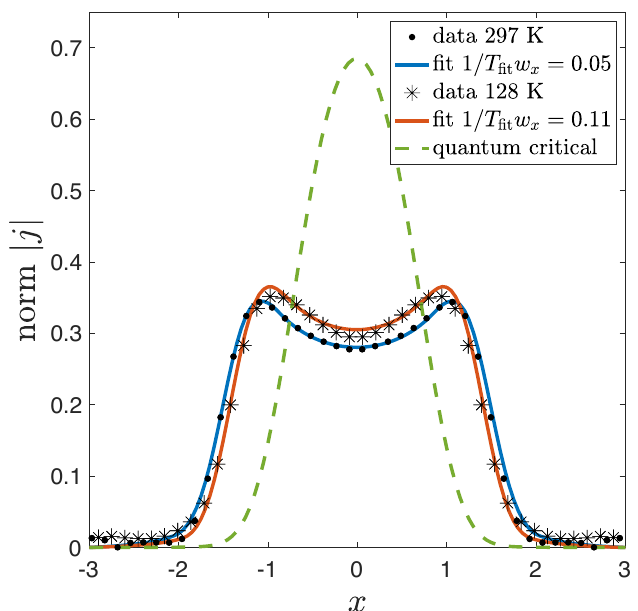
≈ 3 µ m at the charge Figure 4: Normalized current profile | j | across the slit of w x neutrality point at 297 K and 128 K. The solid lines indicate the best fit based on = 0.05 and 0.11 for 297 K and 128 K, respectively, w the holographic model, 1 / T x fit Shown in the dashed green curve is the predicted behavior in a constriction of width 600 nm for the experimental temperature at T = 128 K. Details of the fitting method are provided in the